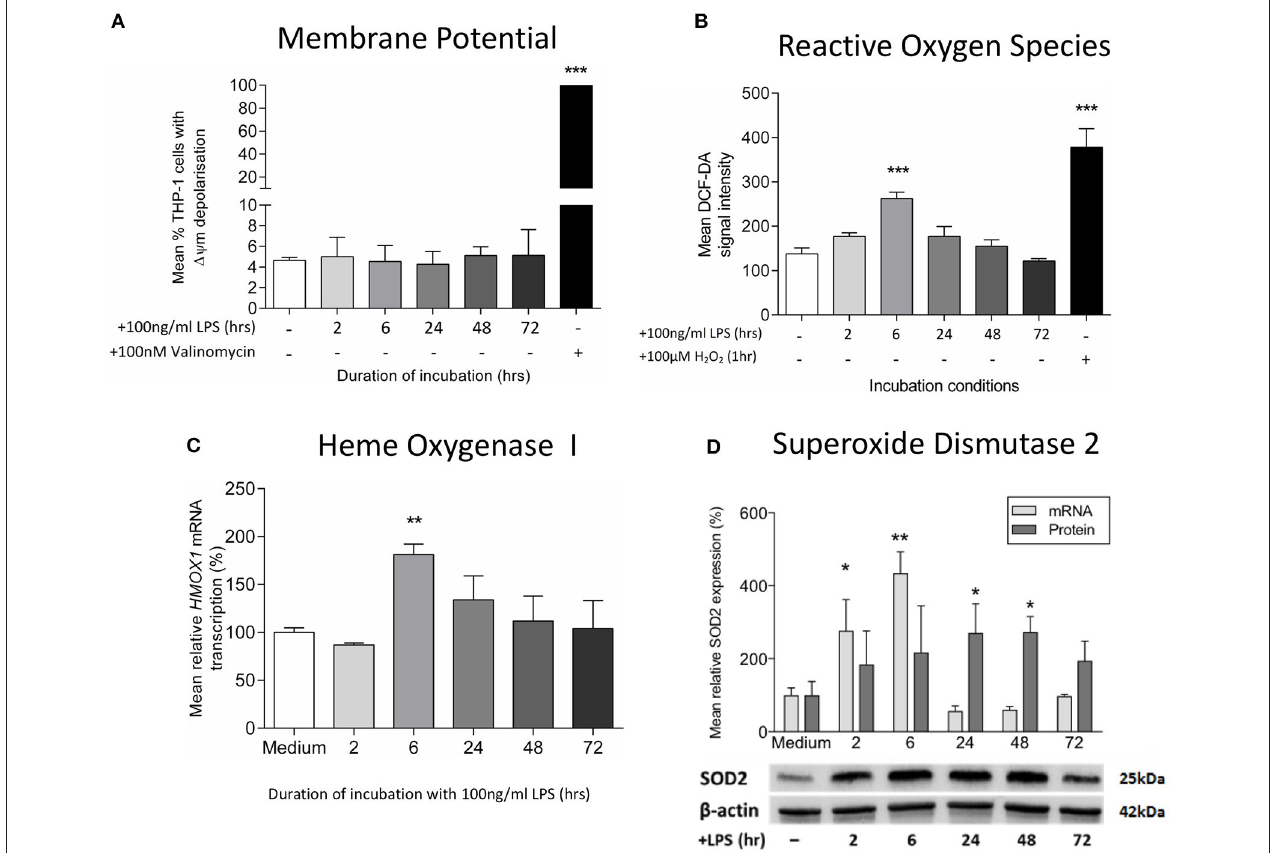
FIGURE 2 | Exposure to LPS leads to early oxidative stress but no increase in mitochondrial membrane potential. Mitochondrial membrane potential ( 1 ψ m) and oxidative stress were assessed following incubation of THP-1 cells with LPS (100ng/ml) for 0–72h. (A) The proportion of THP-1 cells with 1 ψ m was determined by measuring the JC1 fluorescence by flow cytometry (positive control − 100nM valinomycin) ( n = 3). (B) Reactive oxygen species production was measured by oxidation of DCF-DA using flow cytometry (positive control − 100 µ M hydrogen peroxide, H 2 O 2 ) ( n = 3). (C) The mRNA transcription of HMOX1 relative to ACTB and GADPH was determined by RTqPCR ( n = 3). (D) The mRNA transcription (relative to ACTB and GADPH ) and protein expression (relative to β -actin) of SOD2 was measured using RTqPCR and Western blot ( n = 3). Data are presented as mean ± standard deviation (mRNA and protein data are relative to the mean of the medium control); * p < 0.05, ** p < 0.01, *** p <